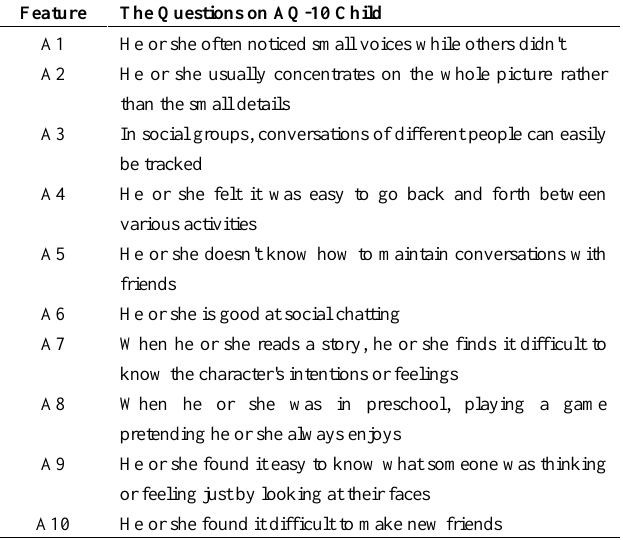
Table 2. Detail Questions on AQ-10